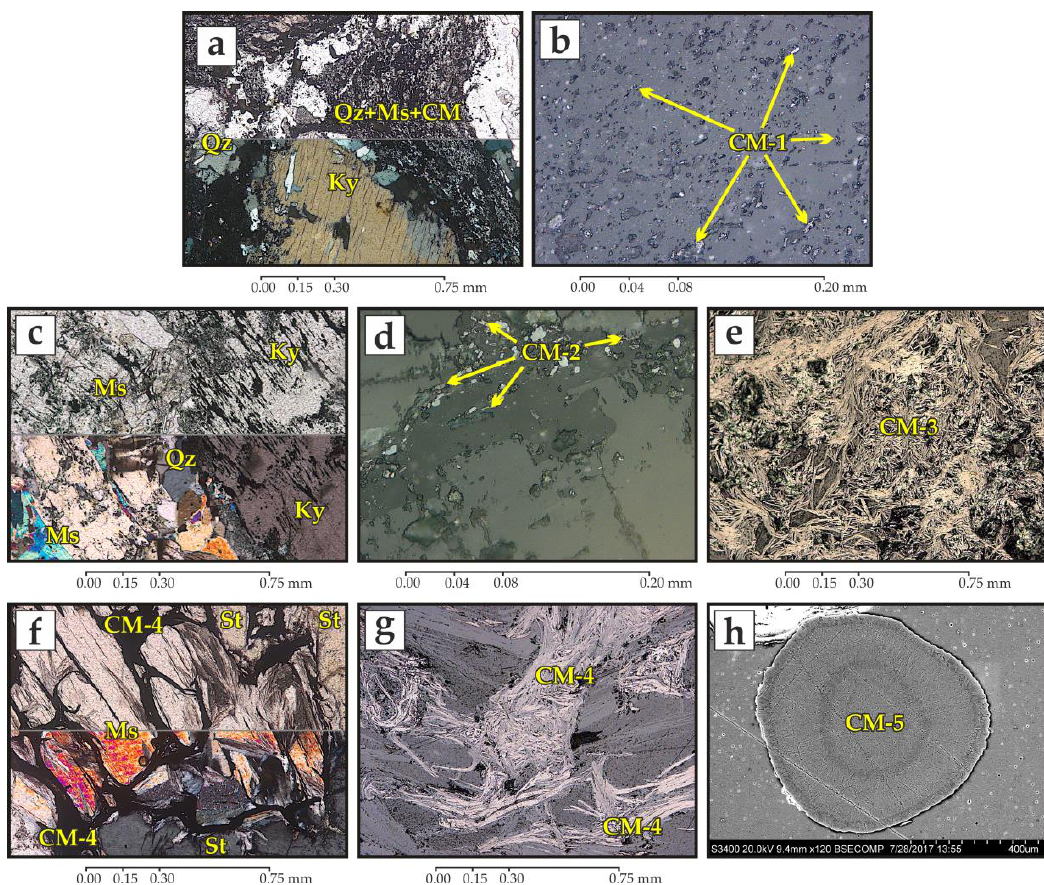
Figure 4. CM morphologies and their position in the studied rocks from the Keivy Terrane: ( a ) Section of a sample of kyanite schist with CM-bearing matrix and ( b ) morphology of fine-grained CM-1 therein; ( c ) interstitial distribution of flaky CM-2 in kyanite-muscovite segregations and ( d ) morphology of CM-2; ( e ) nest of CM-3; ( f ) muscovite-staurolite part of the sillimanite schist veined with CM-4 and ( g ) the morphology of the latter; ( h ) zoning in spherulitic CM-5. Images: ( h ) is a backscattered electron (BSE) photomicrograph; ( a , c , f ) are transmitted light photomicrographs (top—one polarizer, bottom—two polarizers); ( b , d , e , g ) are reflected light photomicrographs. Abbreviations: CM – carbonaceous matter (the numbers correspond to the morphologies, see explanations in the text); Ms—muscovite; Ky—kyanite; Qz—quartz; and St—staurolite.